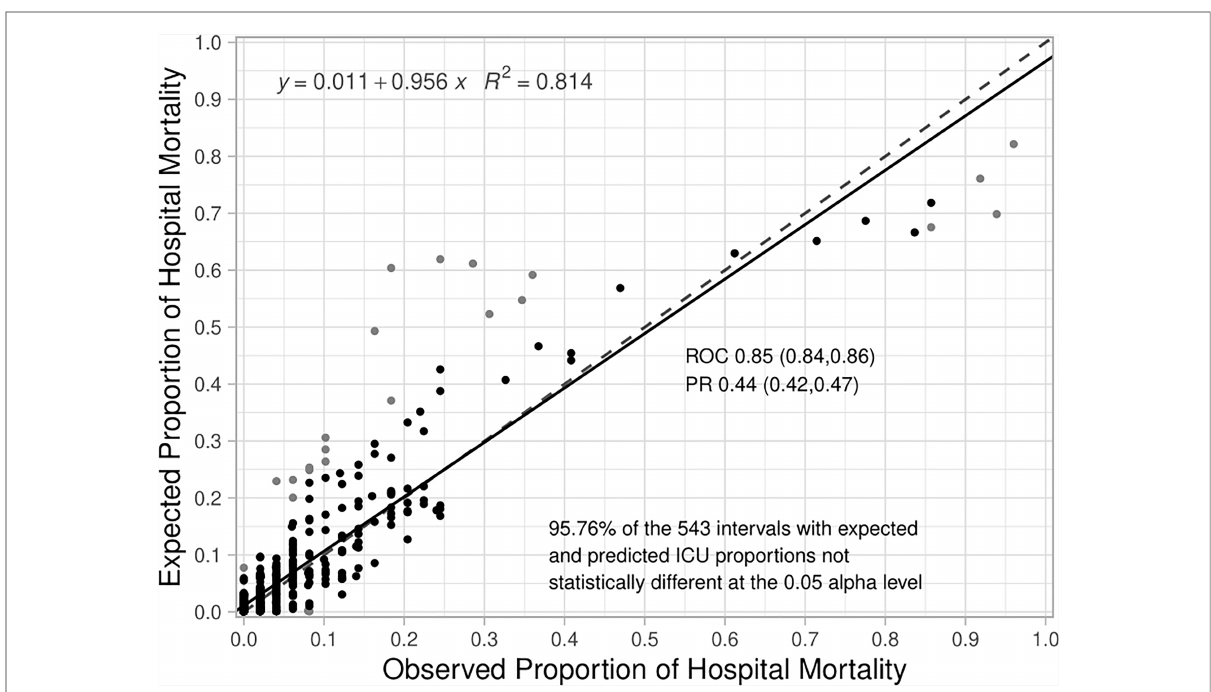
FIGURE 2 Calibration plot for the criticality Index-mortality (CI-M) model . The dashed line is the line of identity and the solid line is the regression line. A statistical test for differences of proportion was computed for each dot in the calibration plot. Each dot is associated with two proportions in a risk interval: 1) observed proportion of ICU mortality (observed count of deaths/total sample), and 2) expected proportion of ICU mortality (predicted count of deaths/total sample). The expected proportion is computed using the risk predictions from the model to predict the count of deaths, the observed proportion is an empirical count of the risk of mortality among the cases in each risk interval. The Santner and Snell test were computed to assess the signi fi cance of the different proportions. The dot is grey if the test results in a p